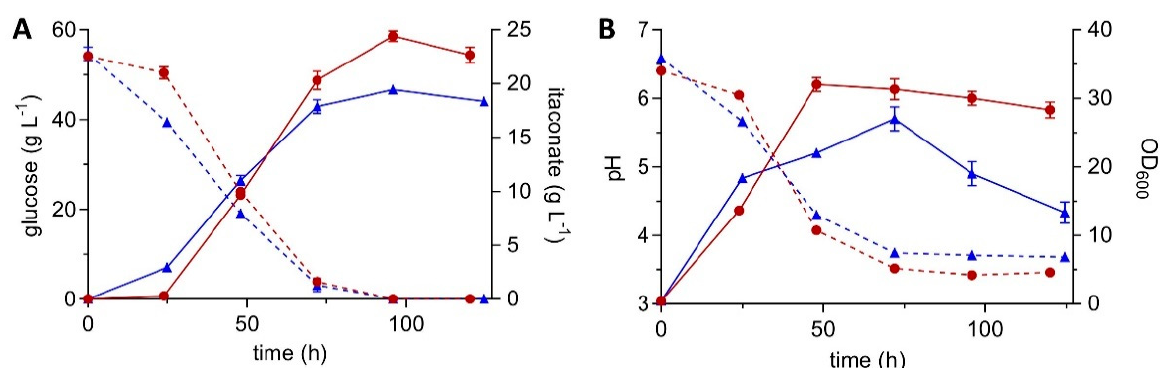
Figure 1. System Duetz ® cultivation of morphology-engineered U. maydis MB215 strains in modified Tabuchi medium (MTM) with 50 g L − 1 glucose and 100 mM (2-(N-morpholino) ethanesulfonic acid (MES), incubated in 24-well plates with a filling volume of 1.5 mL (shaking diameter = 50 mm, n = 300 rpm, T = 30 °C and Φ = 80%). ( A ) Concentrations of itaconate (continuous lines) and glucose (dotted lines), ( B ) optical density measured at a wavelength of 600 nm (OD 600, continuous lines) and pH (dotted lines) of U. maydis MB215 ∆ cyp3 ∆ MEL ∆ UA ∆ dgat ∆ P ria1 :: P etef ( ▲ ) and the same strain with additional fuz7 deletion ( ● ). Error bars indicate the standard error of the mean ( n = 3).